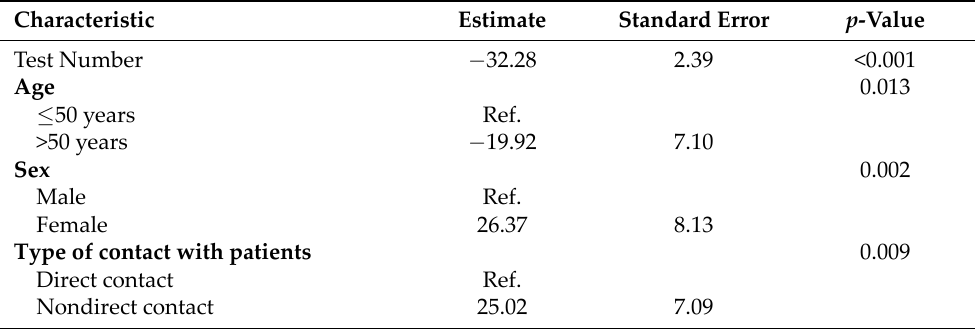
Table 2. Independent effects of sociodemographic and personal background variables on levels of antibodies from the GEE